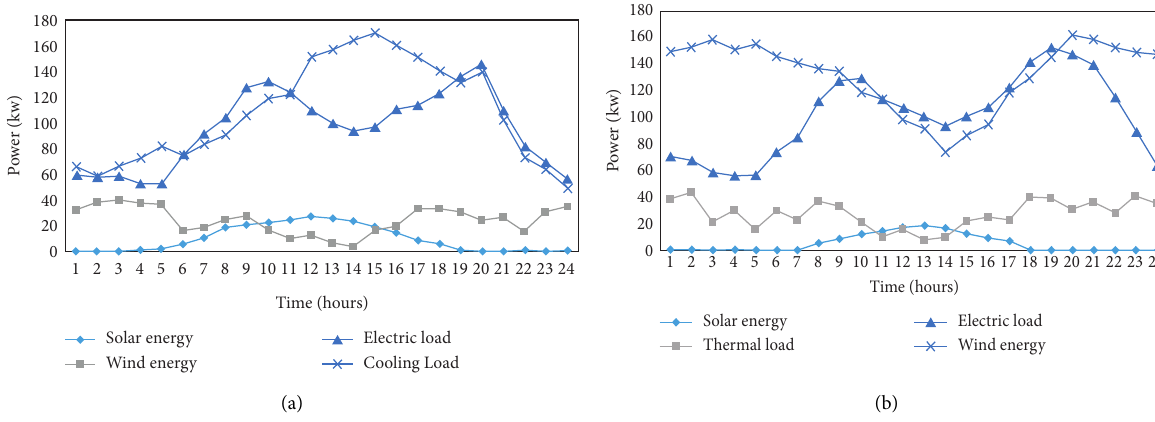
Figure 3: Predictive curves of the wind, photovoltaic output, cooling, heating, and electrical loads in (a) summer season and (b) winter season. Table 1: Operating parameters of the MG